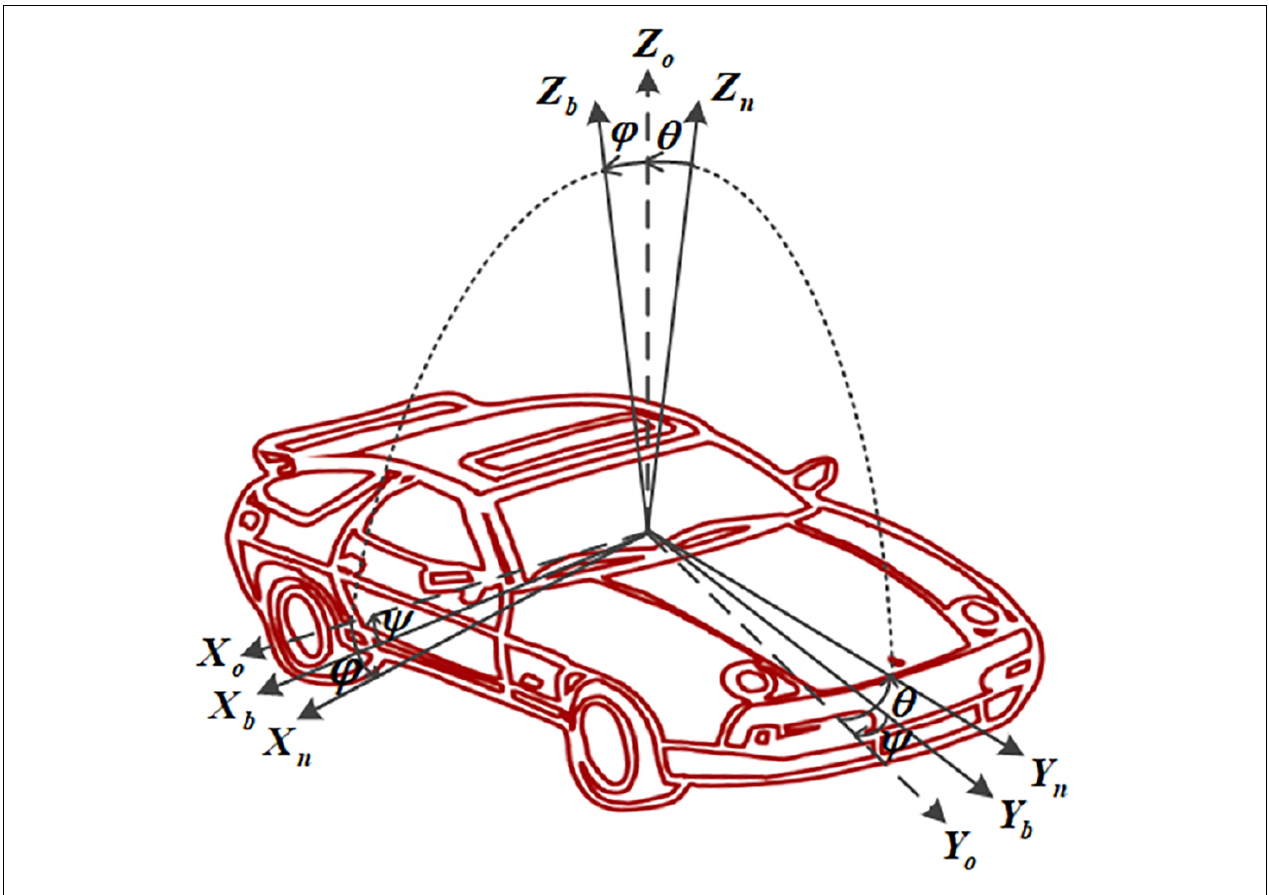
FIGURE 4 | Transformation from body frame (OX b Y b Z b ) to the navigation frame (OX n Y n Z n